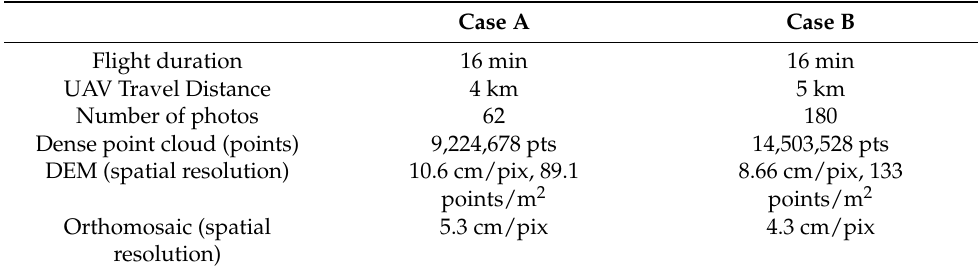
Table 2. Processing characteristics of case A and case B. Case A Case